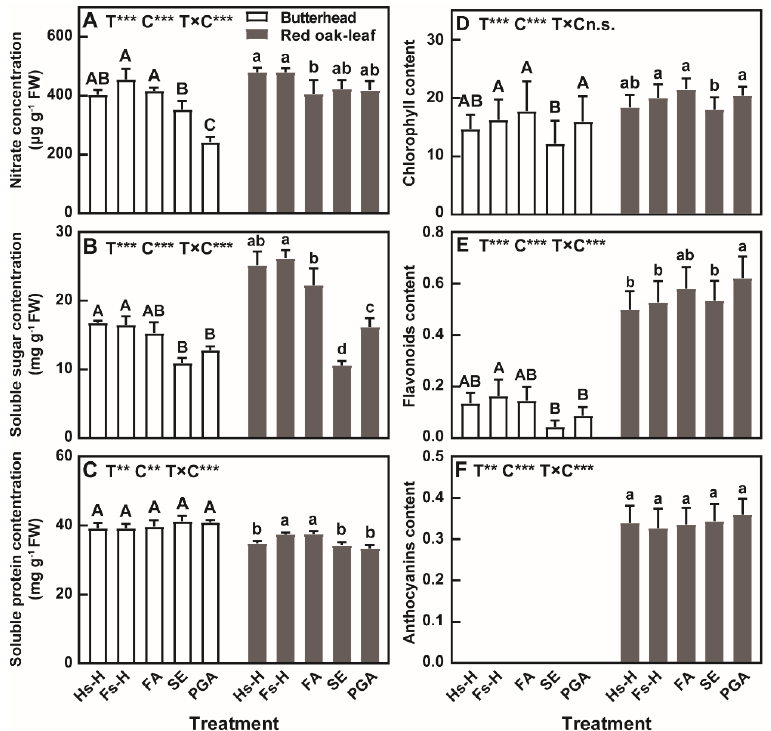
Figure 2. Concentration of ( A ) nitrate, ( B ) soluble sugar, and ( C ) soluble protein, and content of ( D ) chlorophyll, ( E ) flavonoids, and ( F ) anthocyanins in fresh leaves by nutrient solution treatments and lettuce cultivars. Anthocyanin content was below the detection limit for butterhead and is thus not shown here. Data represent mean ± SD ( n = 3, ( A – C ); n = 24 ( D – F )). Different upper- and lowercase letters indicate significant differences among nutrient solution treatments for butterhead and red o ak−leaf, respectively ( α = 0.05). T — main effect of treatment; C — main effect of cultivar; T × C — treatment by cultivar interaction. ** and *** indicate significant difference at α = 0.05, 0.01, and 0.001, respectively; n.s. indicates not significant.